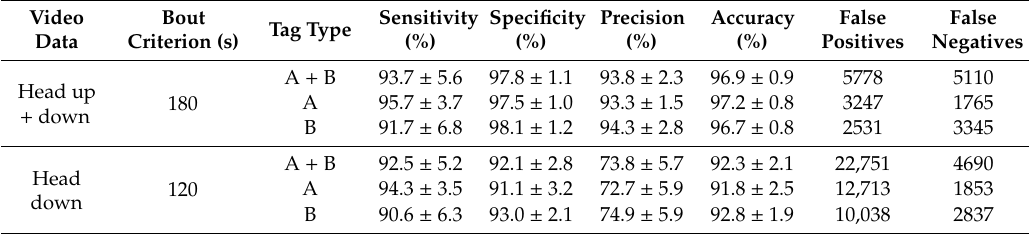
Table 1. Mean ± standard deviation of sensitivity, specificity, precision and accuracy as well as number of false positives and false negatives of the UHF radio-frequency identification (RFID) data validated with two reference data sets of video events with cows ( a ) having their head up and down in front of the feed fence or ( b ) only head